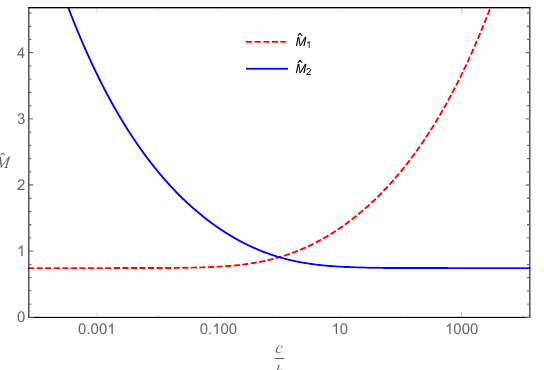
Figure 5. The critical value ˆ M 1 = M 1 /b (red), ˆ M 2 = M 2 /c (blue) as a function of c/b . δh , δc , δφ = δφ } → {8.111, -27.212, 1, 8.832} δa 1 1 11 21 − δφ } → { 1 . 624 , 262 . 692 , − 1 , 68 . 031 } δa 22 values ˆ M = ˆ M = 0 . 908 , which corresponds to the critical phase where four Weyl- Z 1 2 nodes gather together as a single Dirac